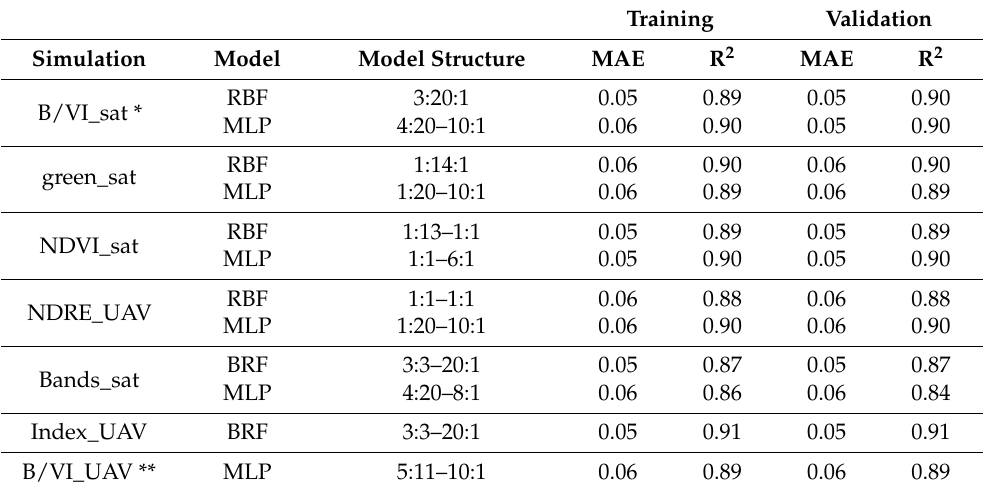
Table 2. Resulting models, topologies, accuracy, and precision of ANN.